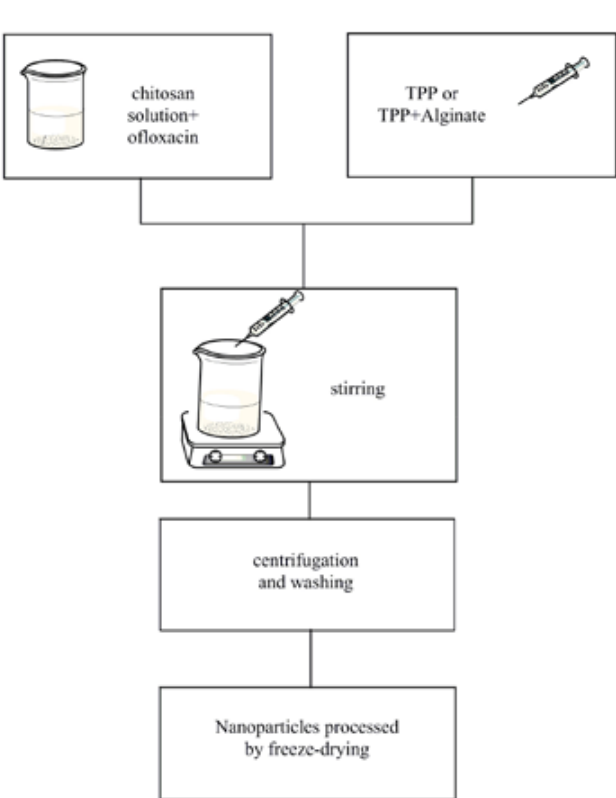
FIGURE 1 - The experimental